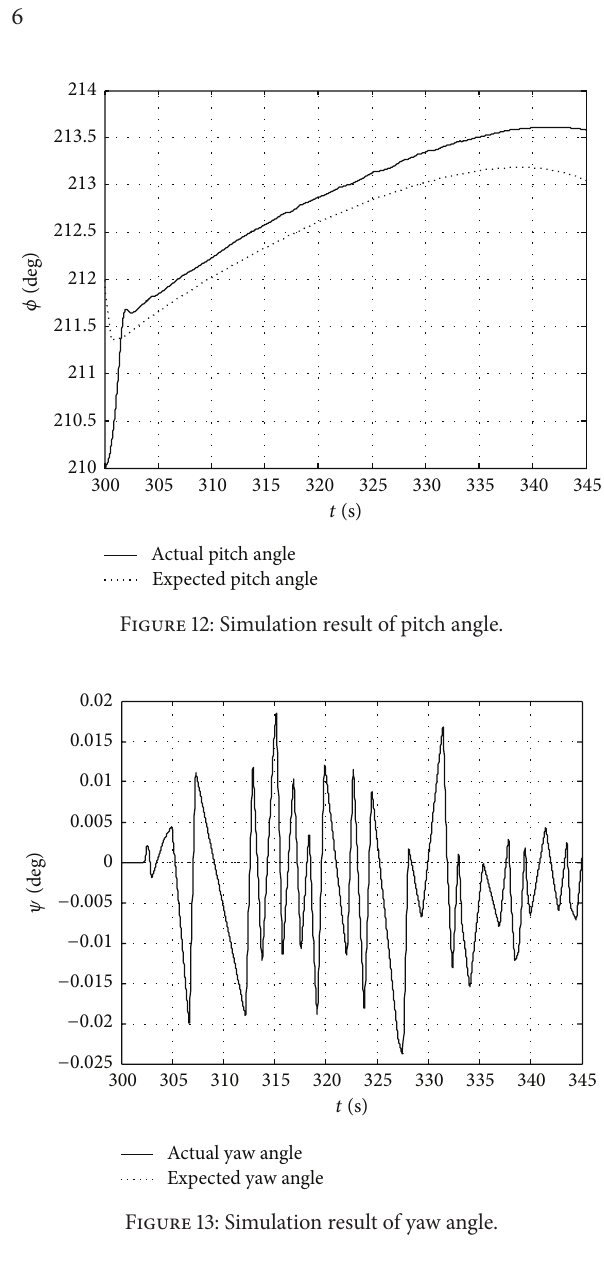
Figure 15: Simulation result of attack